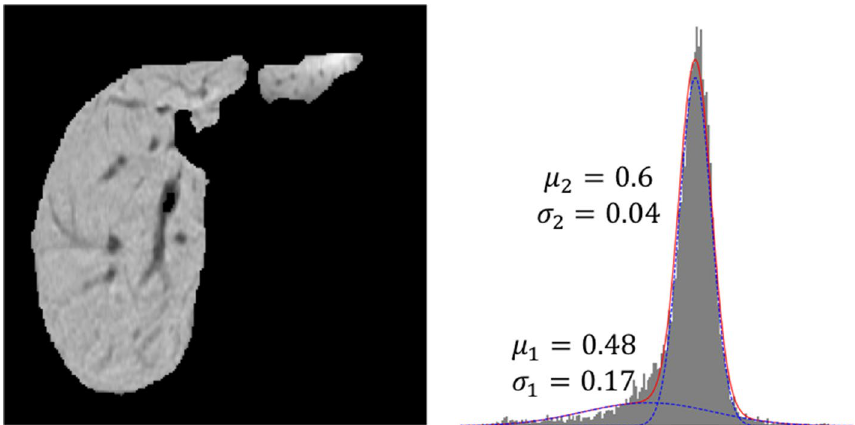
Figure 4. An example of GMM of one liver MR image. The mixture distribution of the image (red line) is well separated by two Gaussian distributions (blue line). The lower curve captures darker blood vessels and the upper curve captures brighter liver background